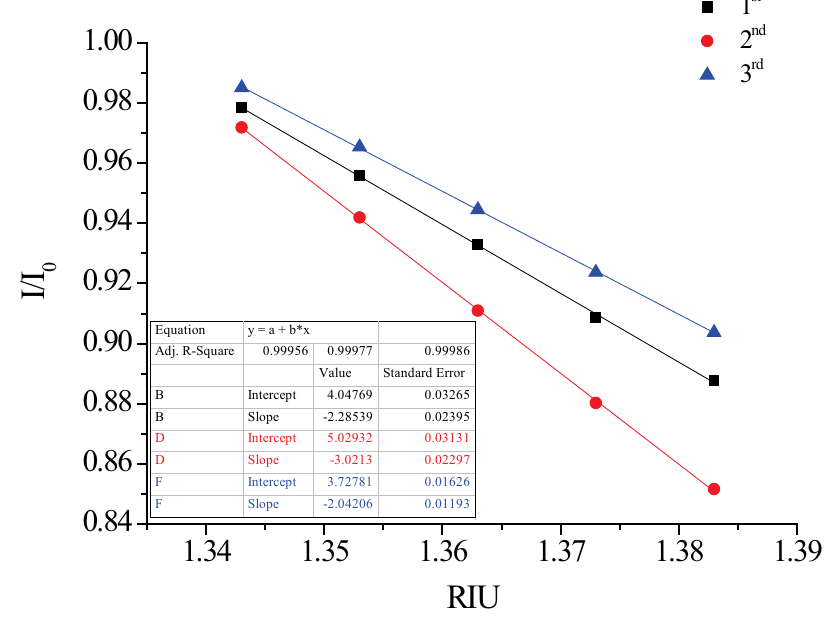
Figure 24. Plot of the PPR fiber sensor response versus the refractive index of the sucrose solution.